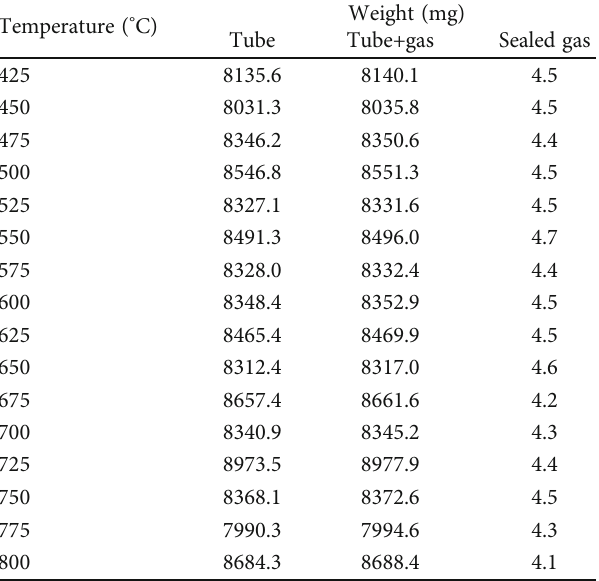
Table 1: Mass of mixture gas sealed in tube for di ff erent temperature